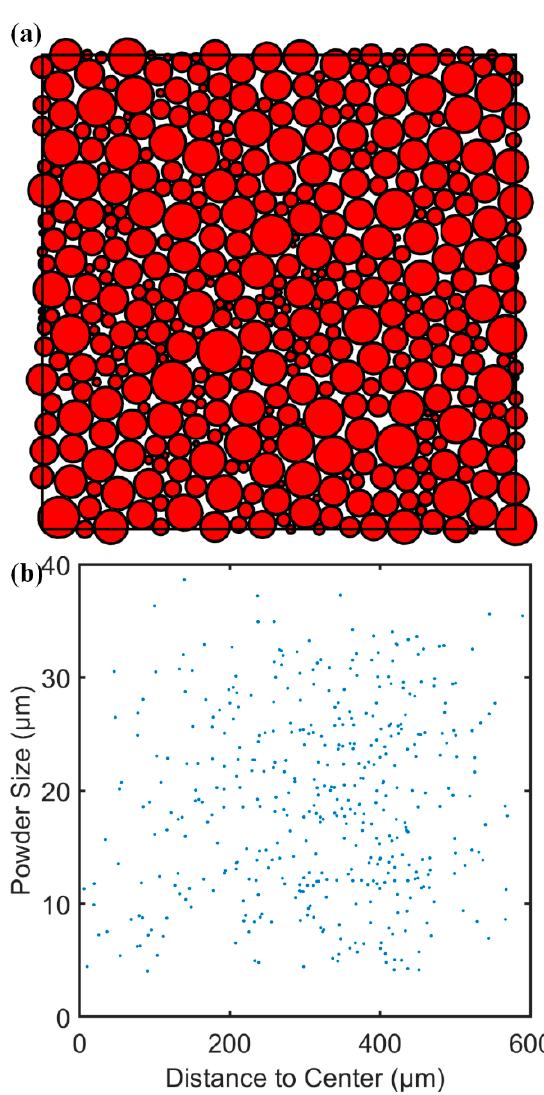
Figure 4. Predicted powder packing structure of ALSi10Mg in this study. ( a ) Packing structure of 500 powders, and ( b ) powder size and center location of 500 packed powders.